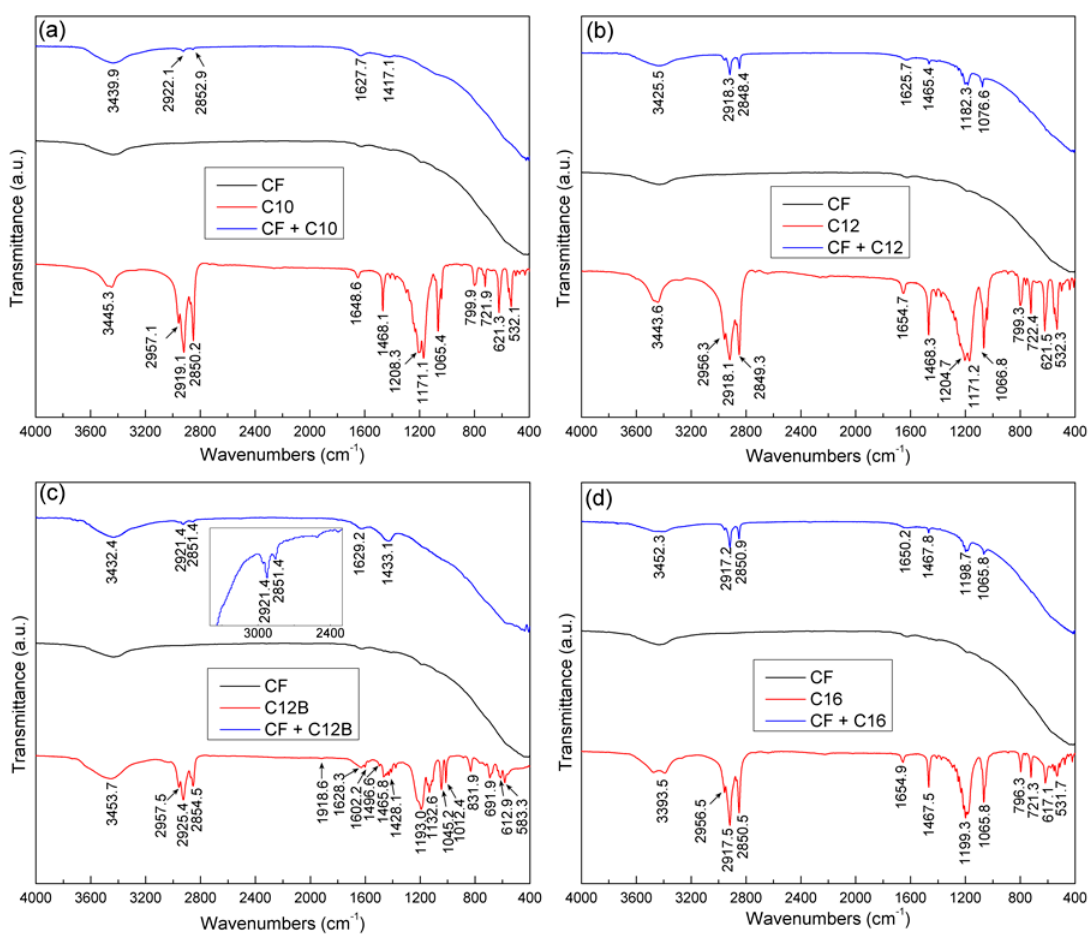
Figure 6. FTIR spectra of fluorites before and after adsorption of sulfonate-based collectors. ( a ) C10; ( b ) C12; ( c ) C12B; and ( d ) C16.